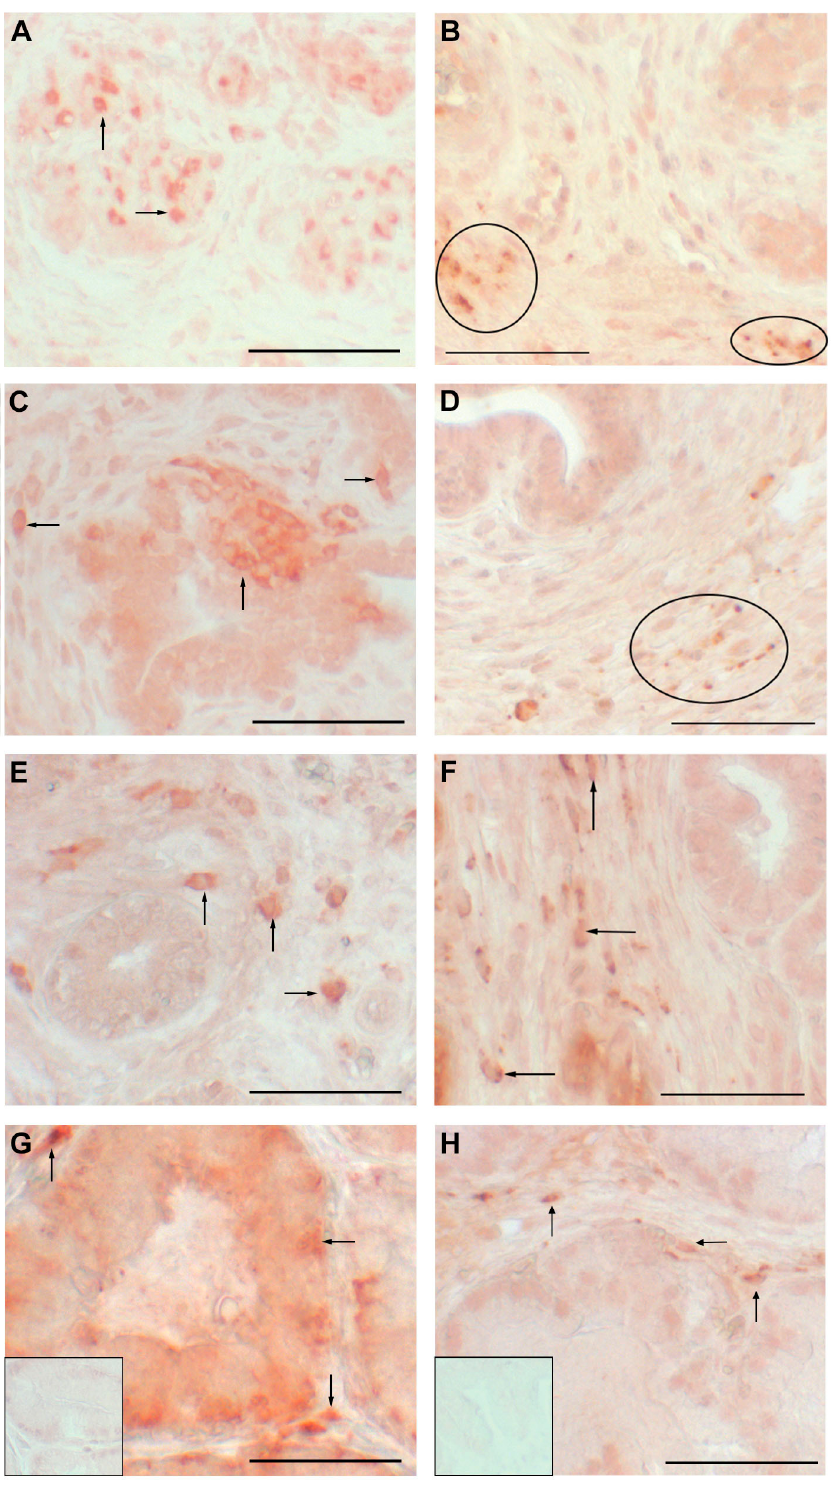
Figure 5. Immunohistochemical localization of leukocytes ( A , C , E , G ) and specifically macrophages ( B , D , F , H ) in the prostate during development. ( A , B ) are sections from prostates from 2-week-old boars; ( C , D ) are prostate sections from 6.5-week-old boars, ( E , F ) are sections from 11-week-old boars; ( G ) is a prostate section from a 40-week-old boar and ( H ) is a prostate section from a 16-week-old boar. Arrows point to individual cells and ovals surround clusters of immunolabeled macrophages. Insets are normal serum controls and similar to the serum controls at other ages. Scale bar is 50 µ